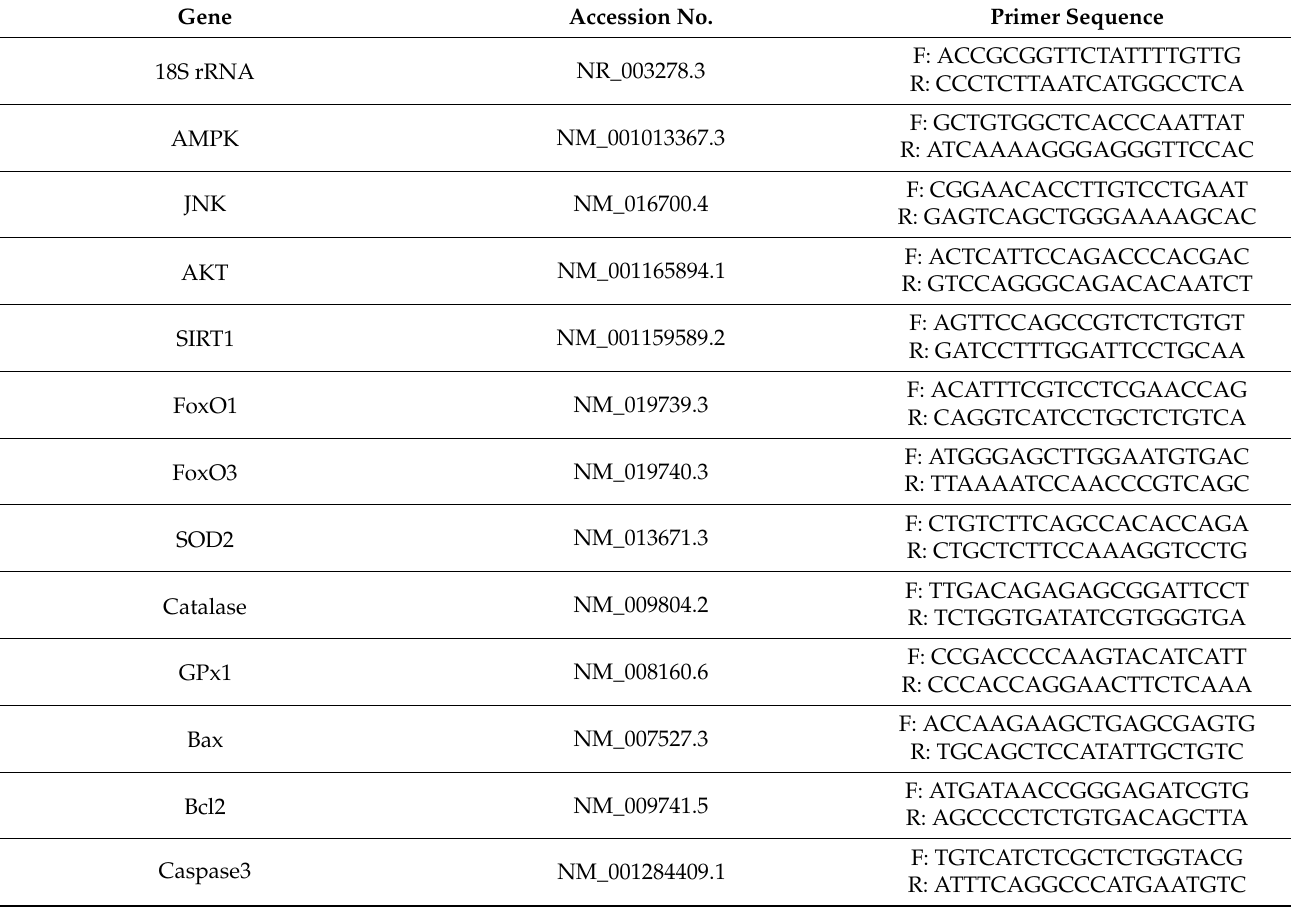
Table 1. List of primer and sequence used for quantitative reverse transcription-polymerase chain